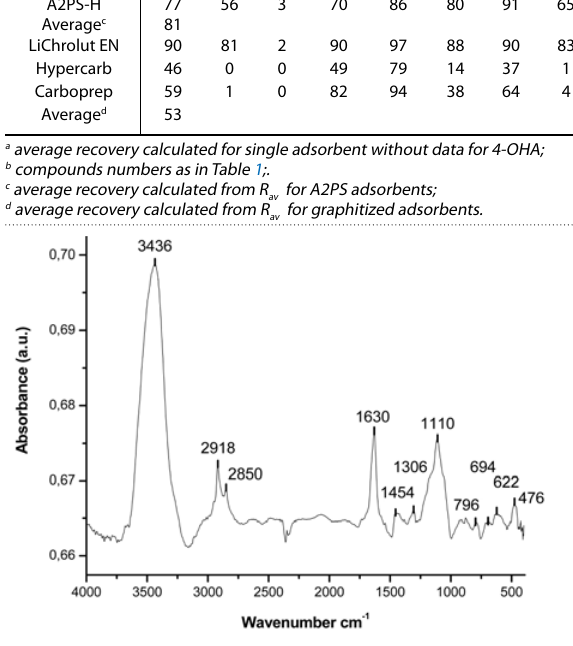
Figure 2. FTIR spectrum of Carboprep.